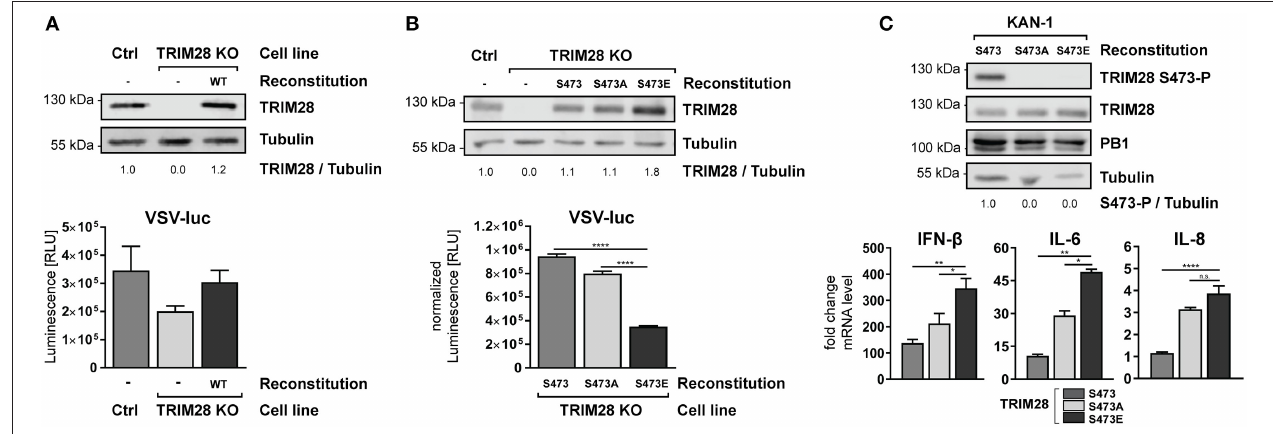
FIGURE 8 | Constitutive TRIM28 S473 phosphorylation potentiates the innate immune response. (A) TRIM28 KO cells were stably reconstituted with wildtype TRIM28 by retroviral transduction. Reconstituted cells were infected with VSV-luc at an MOI of 0.01 for 15h. Cells were harvested and luciferase activity was measured. (B) In addition to wildtype TRIM28, phospho-mimetic variants (S473A and S473E) were stably reconstituted in TRIM28 KO cells. VSV-luc infection was carried out as described in (A) . Results are depicted as mean RLU ( ± SEM) normalized to TRIM28 expression. **** p ≤ 0.0001; one-way ANOVA; Dunnett’s multiple comparisons test. (C) Stably reconstituted TRIM28 KO cells were infected with KAN-1 at an MOI of 0.01. Total RNA was isolated 24h p.i. and IFN- β , IL-6 and IL-8 mRNA levels were measured by qRT-PCR. mRNA levels are depicted as mean n -fold change ( ± SEM) over non-infected cells. n.s. p > 0.03, * p ≤ 0.03; ** p ≤ 0.002; **** p ≤ 0.0001; one-way ANOVA; Dunnett’s multiple comparisons test.